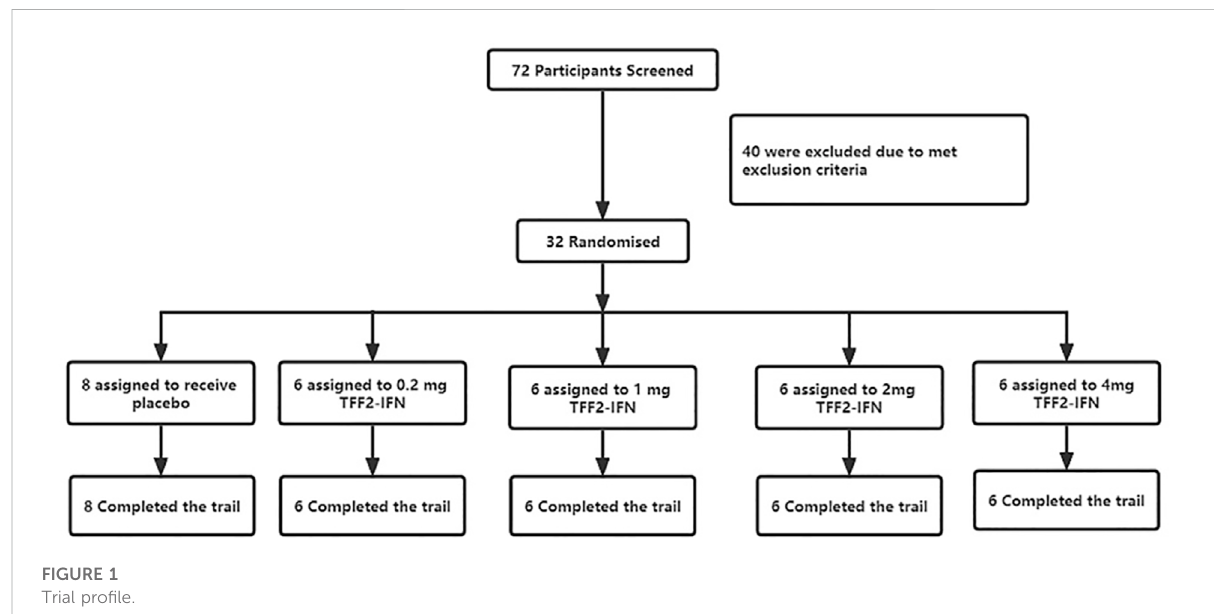
FIGURE 1 Trial pro fi